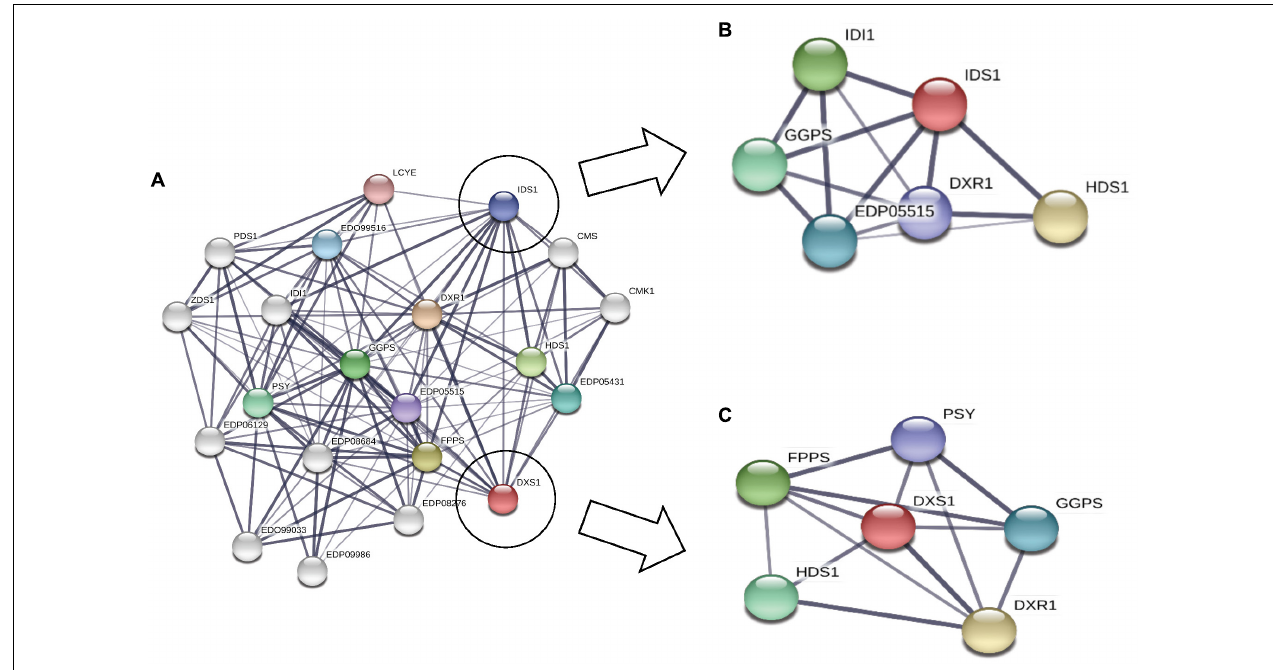
FIGURE 6 | Subcellular network prediction using STRING database: (A) complete network where each node represents a particular protein of methyl erythritol phosphate (MEP) pathway protein; (B) subnetwork of IDS1 protein representing interaction with GGPS and DXR1; (C) subnetwork of DXS1 protein interacting with farnesyl diphosphate farnesyl synthase (FPPS) (squalene biosynthesis) and phytoene synthase (PSY) (carotenoid biosynthesis).